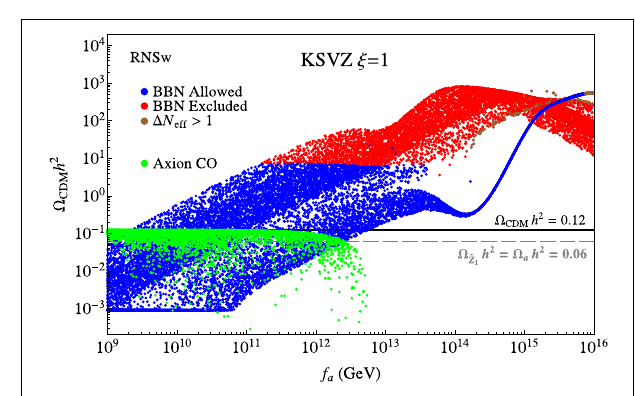
FIGURE 7 | The wino-like WIMP and axion relic densities from a scan over SUSY KSVZ parameter space for the RNSw benchmark case with ξ = 1 . The gray dashed line shows the points where DM consists of 50% axions and 50% neutralinos.